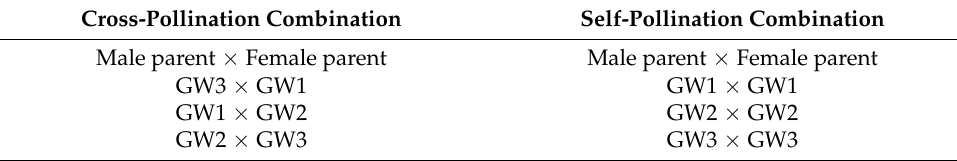
Table 1. Self- and cross-pollination combinations of C. weiningensis . Cross-Pollination Combination Self-Pollination